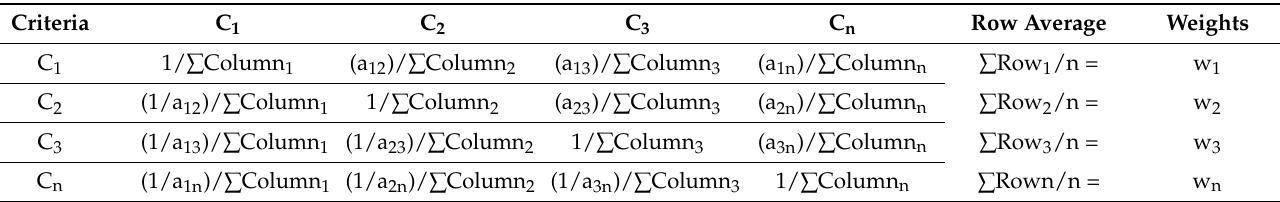
Table 2. Development of the normalised matrix